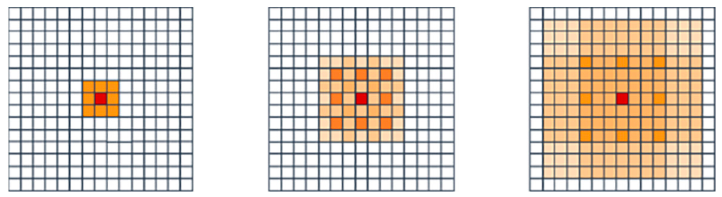
Figure 4. Different dilation rates of convolution layers. From left to right, r = 1, 2, 3, respectively.